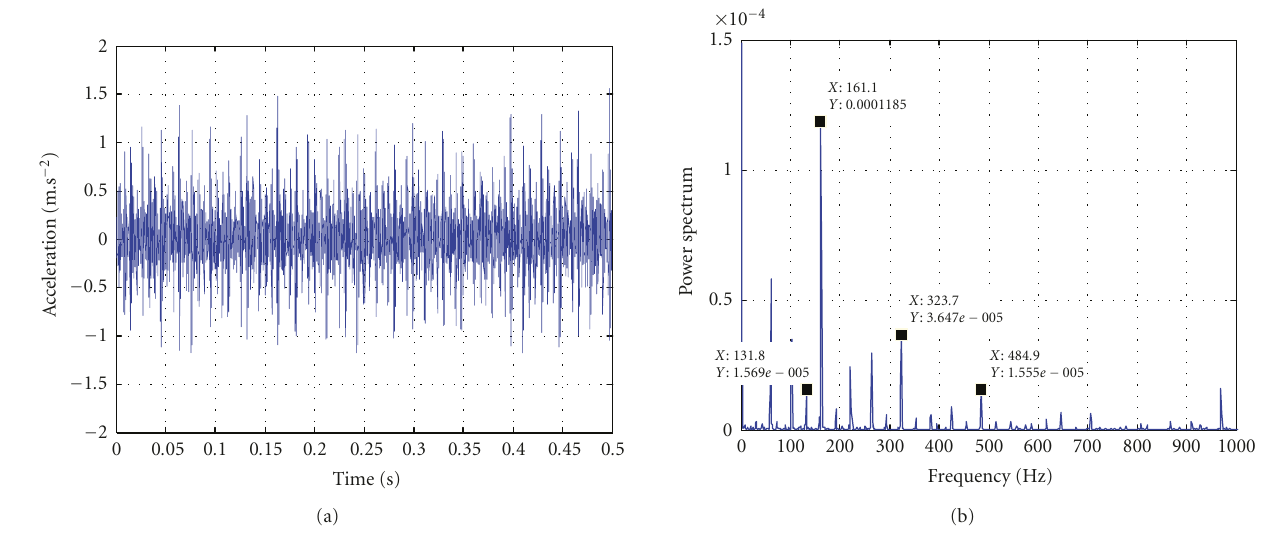
Figure 12: The vibration signal (a) and the corresponding TWPS (b) for rolling bearing with inner-race fault (CWRU data).